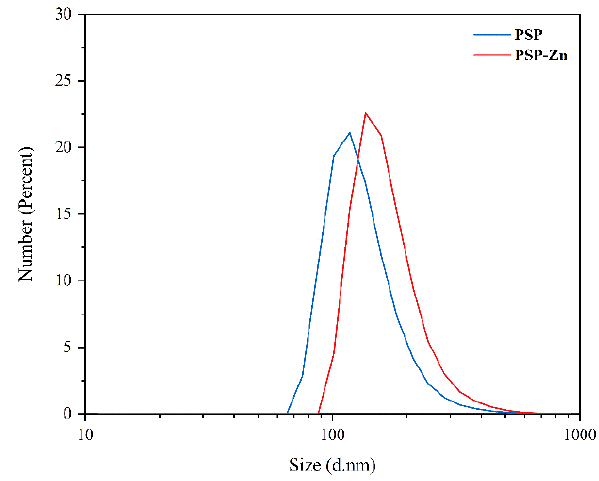
Figure 4. The particle size of PSP and PSP − Zn.